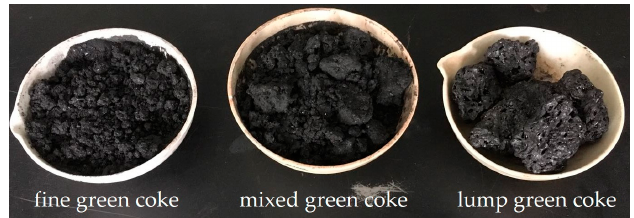
Figure 6. Three different green cokes used in the experiment.